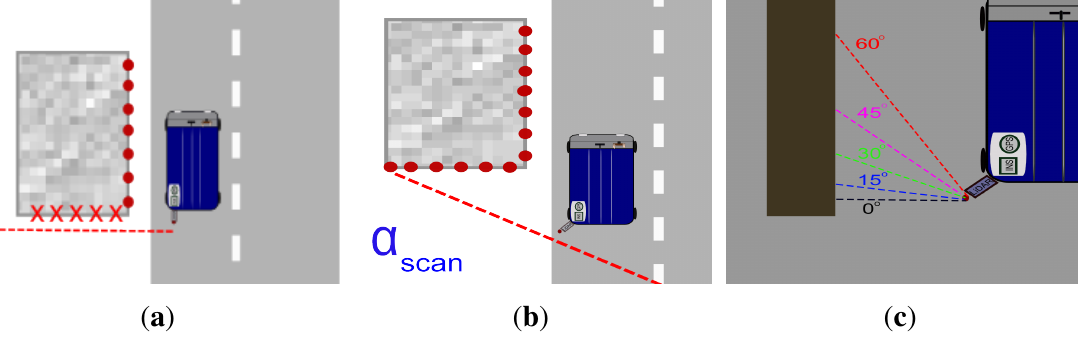
Figure 1. Issues related to a horizontal scanner orientation for an MMS: ( a ) no rotation results in zero pulses striking a perpendicular target, ( b ) a horizontal rotation ( α results in pulses striking that surface, ( c ) horizontal rotations also result in an increased range to